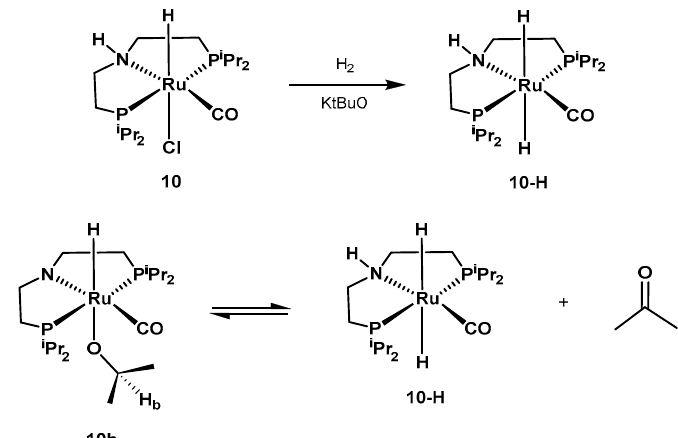
Scheme 2. ( a ) Pincer complexes screened by Beller in 2011; ( b ) low temperature isopropanol dehydrogenation; ( c ) proposed outer-sphere mechanism [219].